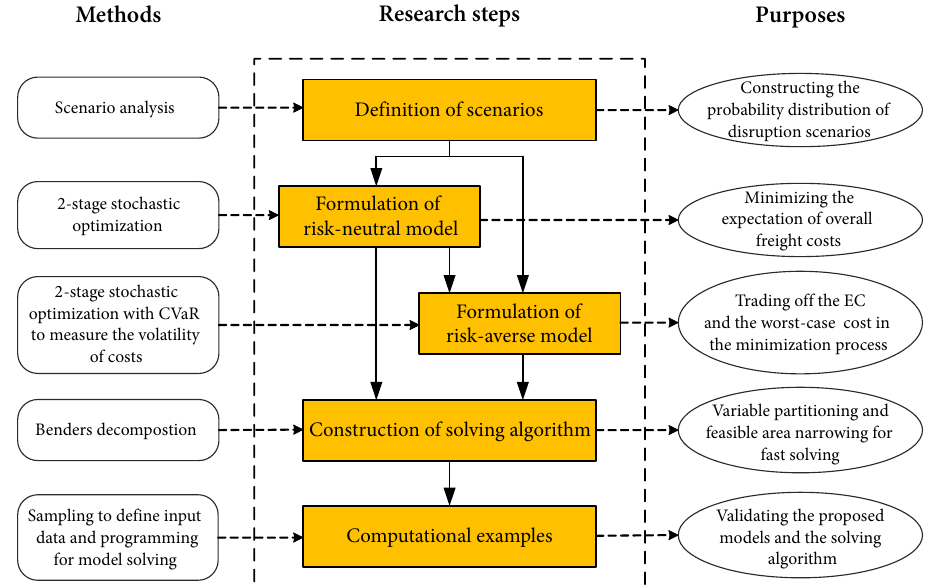
Figure 2. The flow chart of the research